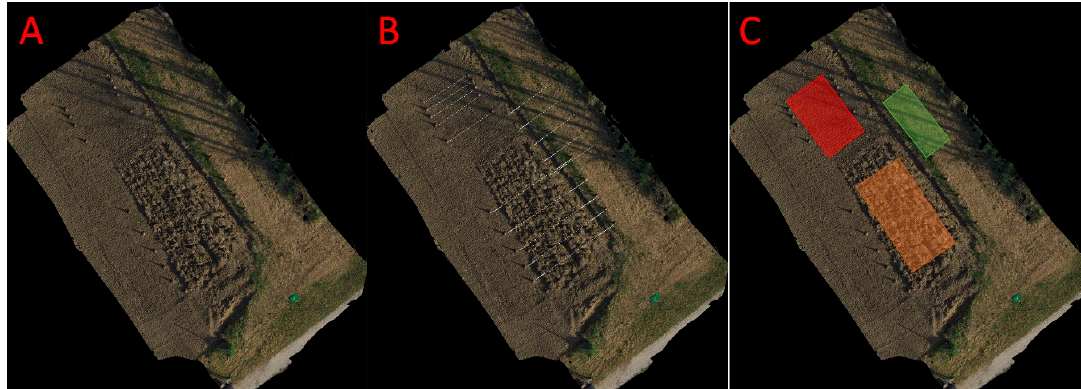
Figure 3 . The reconstructed orthoimage ( A ) overlapped with the transects ( B ); white dashed lines) and area for the texture parameters extraction ( C ); Orange = ploughed, red = harrowed and green = grassed).